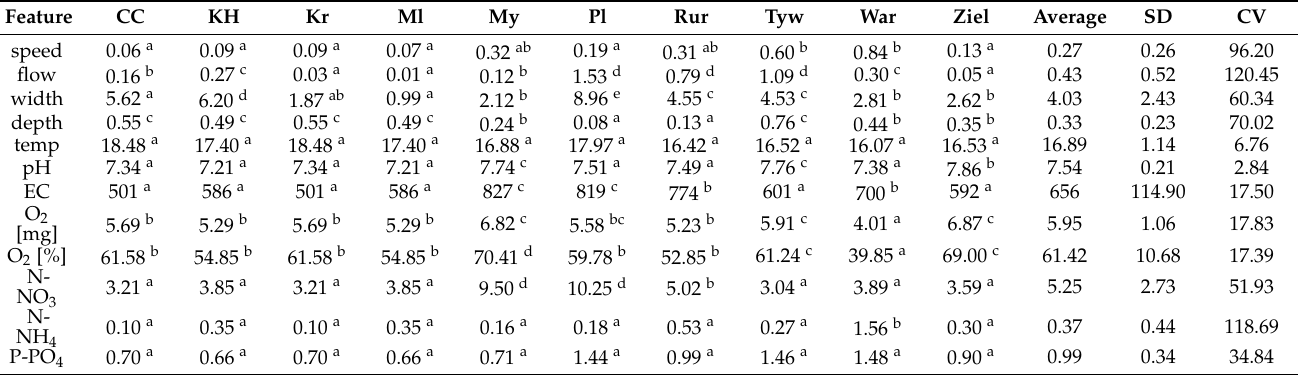
Table 2. Physicochemical and hydrological conditions of the watercourses with results of Tukey’s test.